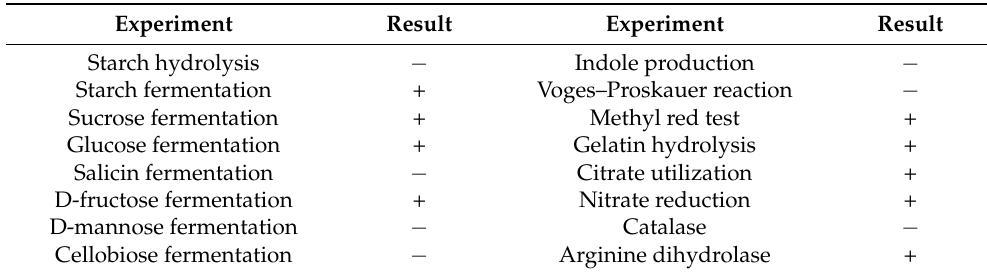
Table 1. The physiological and biochemical characteristics.